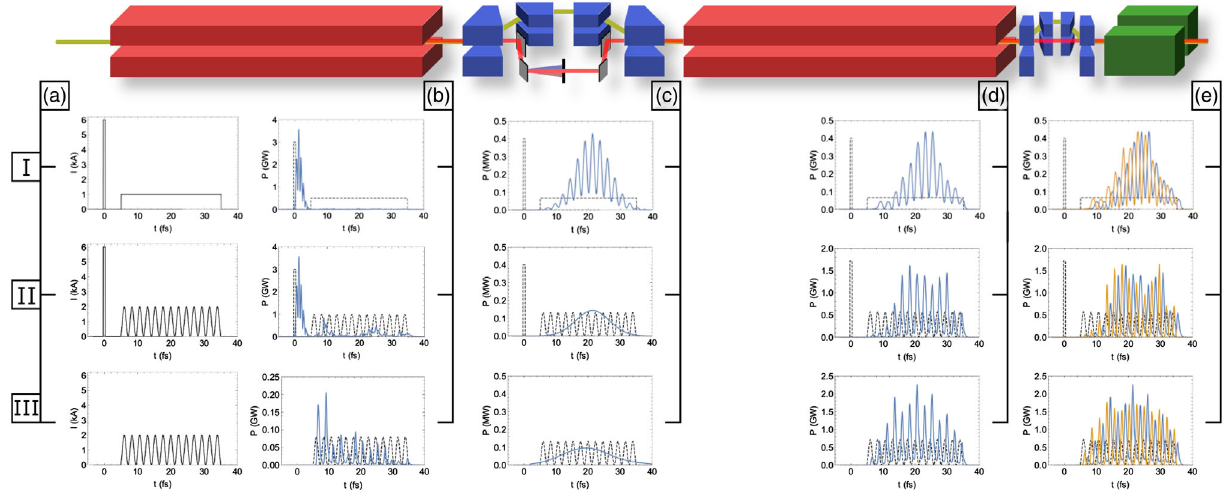
(yellow).FIG. 4. Illustration of the methods considered for generation of time dependent polarization, showing the initial current profile (a), the SASE radiation generated before self seeding (b), the seed pulse after the self seeding monochromater (c), the s -polarization pulse (d), and the combined s and p -polarization (blue, yellow) after the delay and crossed undulator (e), for two-color ESS (I), ESS with current modulation (II) and regular SS with current modulation